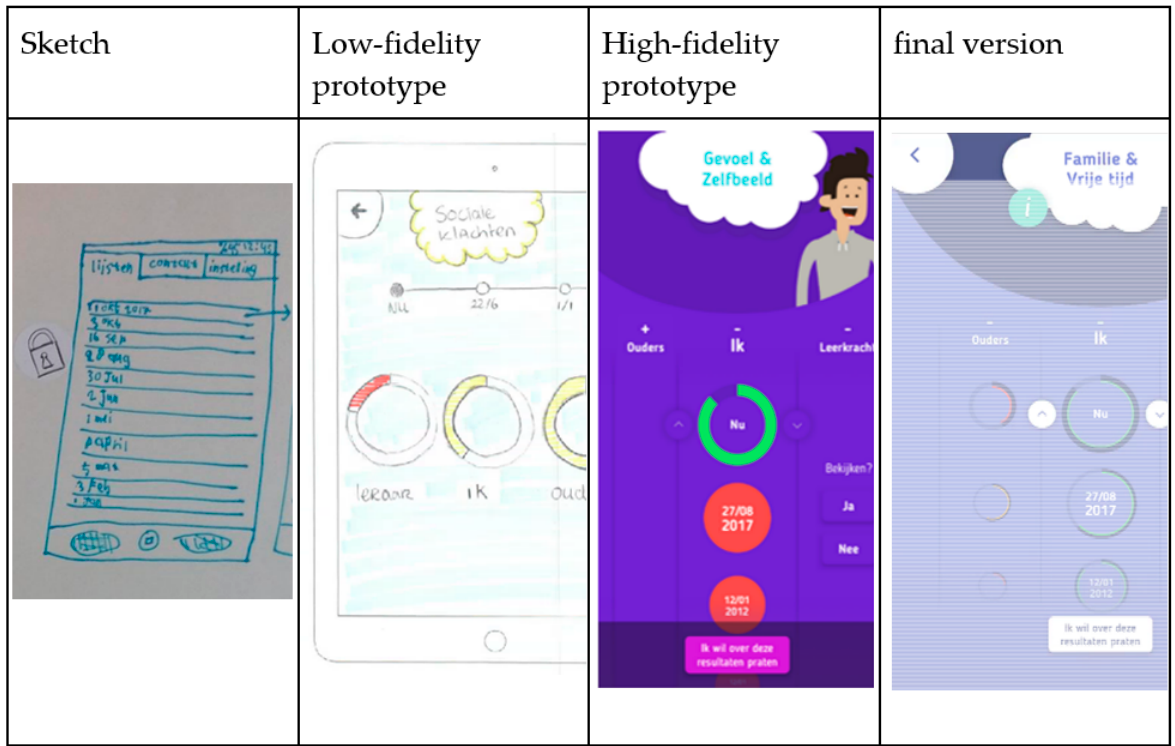
Figure 3. Youngsters indicated that a well-organized application was essential.